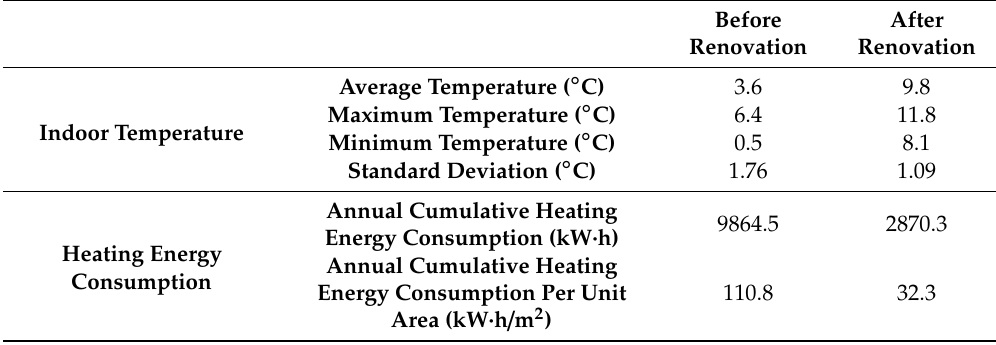
Figure 23. The annual cumulative heating energy consumption before and after renovation of all parts. Table 9. The data comparison of temperature and energy consumption before and after renovation of all parts.